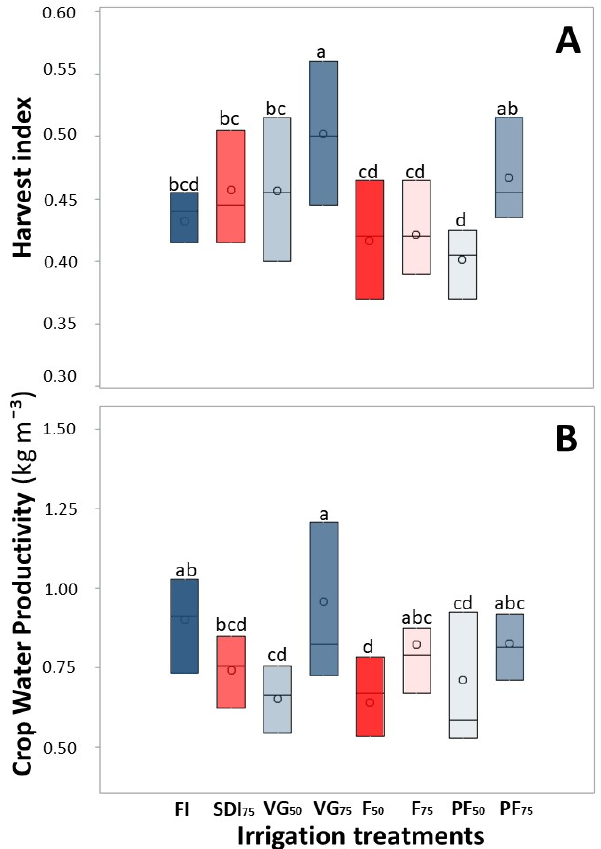
Figure 6. ( A ) Harvest index and ( B ) crop water productivity of chickpeas under different irrigation treatments in Todos Santos, Baja California Sur, Mexico. Vegetative growth (VG), flowering (F), and pod-filling (PF) stages. RDI = regulated deficit irrigation. FI = full irrigation application of 100% ETc during VG, F, and PF. SDI 75 = sustained deficit irrigation applying 75% of ETc during VG, F, and PF. VG 50 = RDI applying irrigation equivalent to 50% of ETc in VG. VG 75 = RDI applying irrigation equivalent to 75% of ETc in VG. F 50 = RDI applying irrigation equivalent to 50% of ETc in F. F 75 = RDI applying irrigation equivalent to 75% of ETc in F. PF 50 = RDI applying irrigation equivalent to 50% of ETc in PF. PF 75 = RDI applying irrigation equivalent to 50% of ETc in PF. abcd Different letter among treatments indicates statistical significance ( p ≤ 0.05, LSD). More intense blue in box plot indicates higher total irrigation volume, and more intense red in box plot indicates lower total irrigation Table 8. Di ff erences (%) in harvest index (HI) and crop water productivity (CWP) among irrigation treatments.